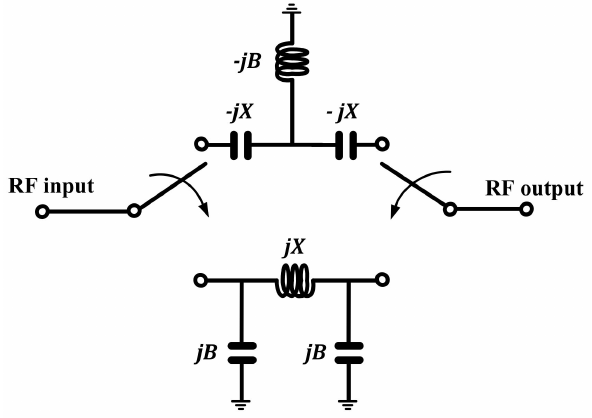
Figure 2. Schematic of the high-pass/low-pass phase shifter.